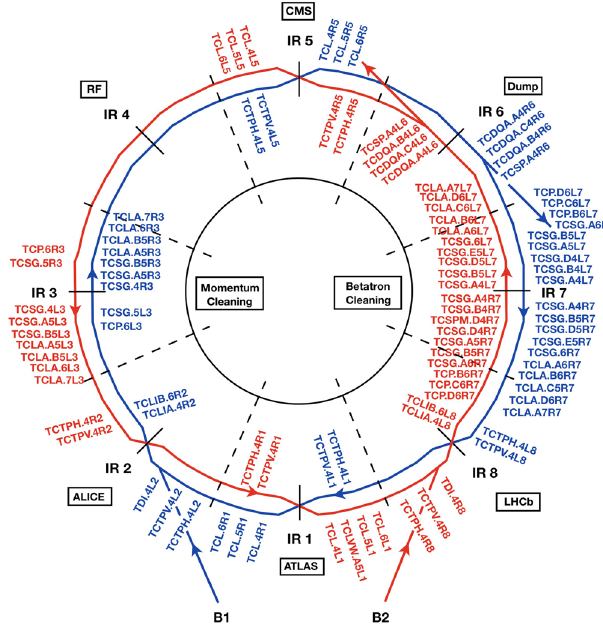
FIG. 2. 2018 LHC collimation system layout [31] for B1 (in blue) and B2 (in red). The names and locations of the different IRs are also